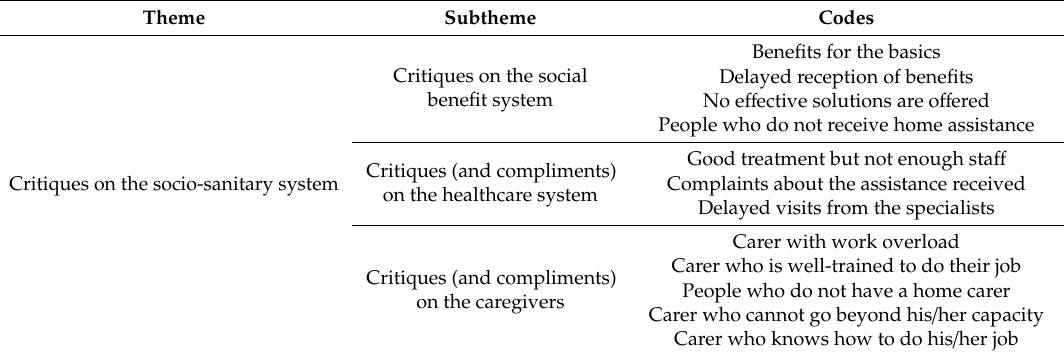
Table 6. Theme, subthemes, and codes related to the satisfaction of social needs of PCDD (continuation).